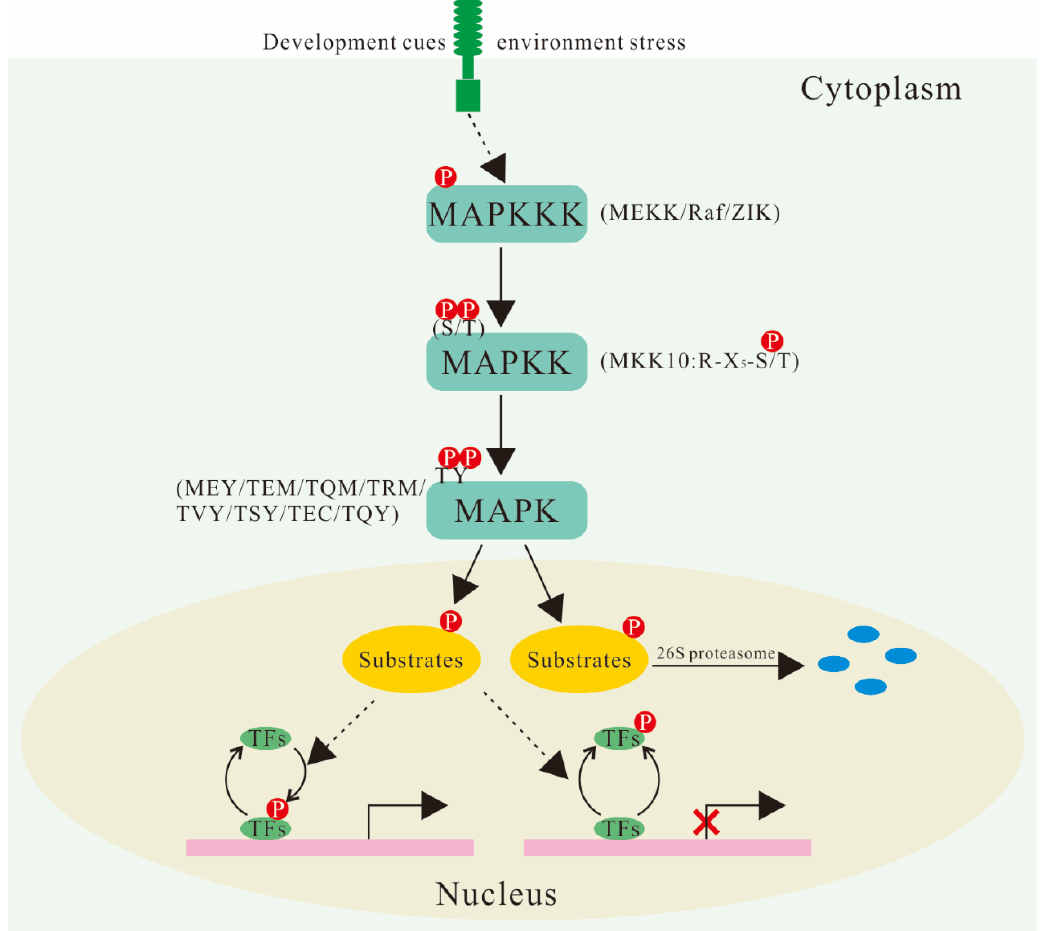
Figure 1. Schematic representation of MAPK cascade. A signal transduction cascade navigates the signal from MAPKKK to MAPK by triggering a series of Thr/Tyrosine (Tyr) and Ser/Thr phosphorylation events. Eventually, the activated MAPK is transported to the nucleus, where it is involved in the phosphorylation of transcription factors (TFs) and reconfigures a specific response related to transcriptional reprogramming. Phosphorylated substrates can be degraded by 26S proteasome or activated, and they can thus change the binding affinity with the promoter of the target gene to suppress or promote its expression. MAPKKK can fall into three subfamilies: MEKK, Raf (Rapidly Accelerated Fibrosarcoma), and ZIK (ZR1-interacting kinase). Compared with typical MKKs, the active loop of MKK10 displayed only a partially conserved Ser/Thr site (R-X 5 -S/T). The phosphorylation sites of MAPKs at their TXY activation loop include various forms, such as TEY (Thr-Glu-Tyr), TDY (Thr-Asp-Tyr), MEY (Met-Glu-Tyr), TEM (Thr-Glu-Met), TQM (Thr-Gln-Met), TRM (Thr-Arg-Met), TVY(Thr-Val-Tyr), TSY (Thr-Ser-Tyr), TEC (Thr-Glu-Cys), and TQY (Thr-Gln-Tyr). The circled P indicates phosphorylation; the blue circle indicates degraded protein.